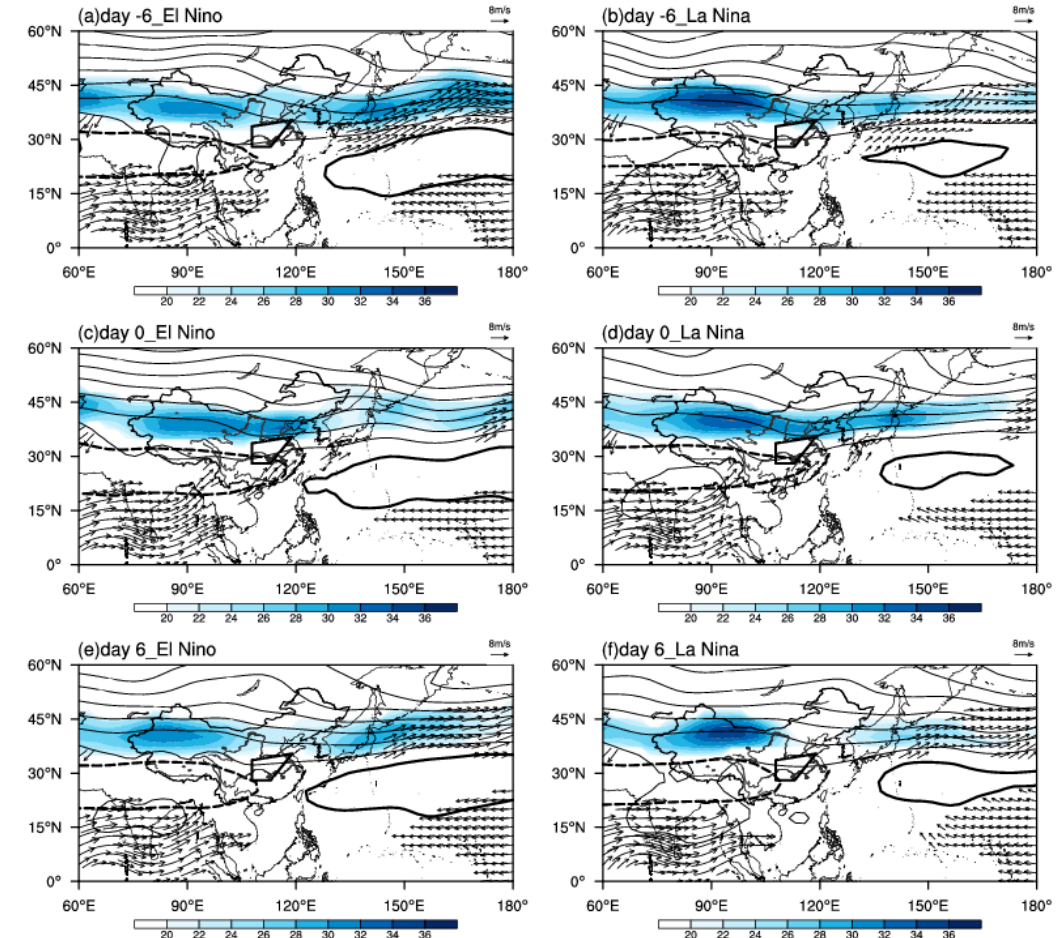
Figure 4. Lead-lag composite analysis of unfiltered westerly jet (blue shaded areas, units:m · s − 1 ) and the South Asia High (SAH, dashed line denotes 12,520 gpm (geopotential height) characteristic line) at 200 hPa, wind fields at 850 hPa (vector, units: m · s − 1 ), geopotential height fields at 500 hPa (solid line, thick solid line denotes 5880 gpm characteristic line) during the low-frequency precipitation in the following summer of CP El Niño ( a , c , e ) and CP La Niña ( b , d , f ).